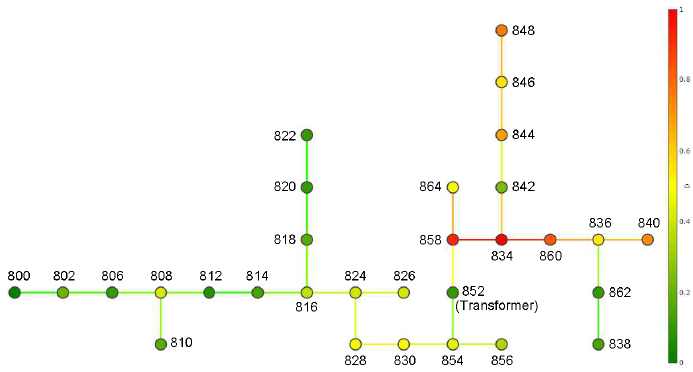
Figure 16. D function graphical representation for Base Case